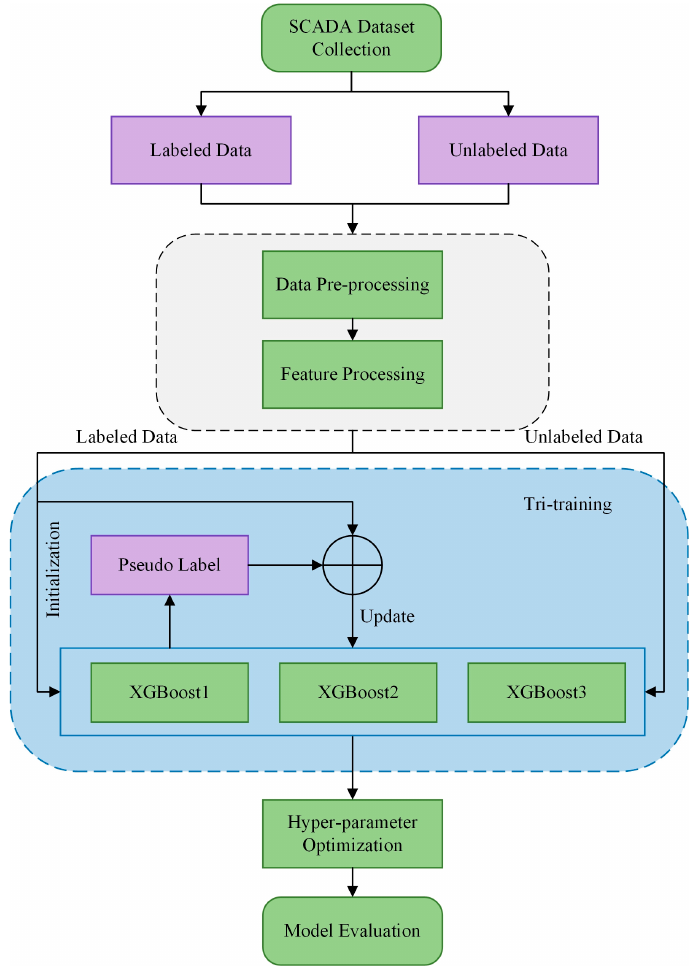
Figure 2. Blade icing detection modeling flow chart.